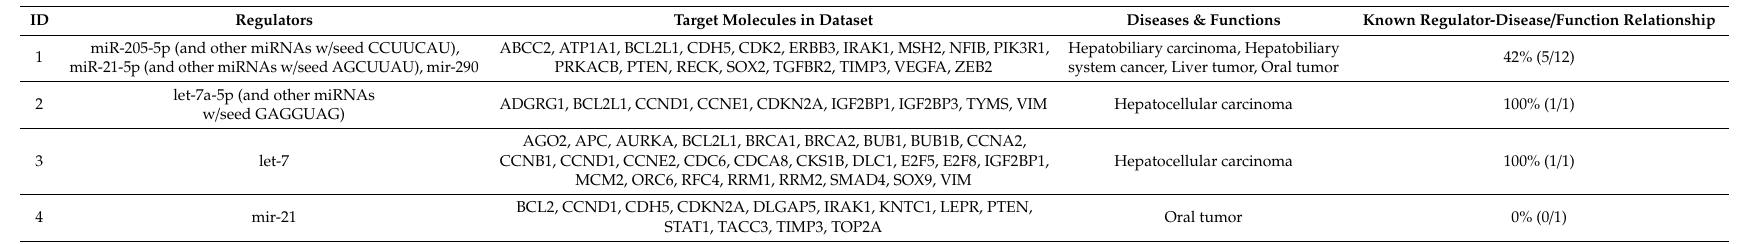
Table 5. MicroRNA (miRNA)-related regulator e ff ect networks in intestinal-type gastric cancer (GC).